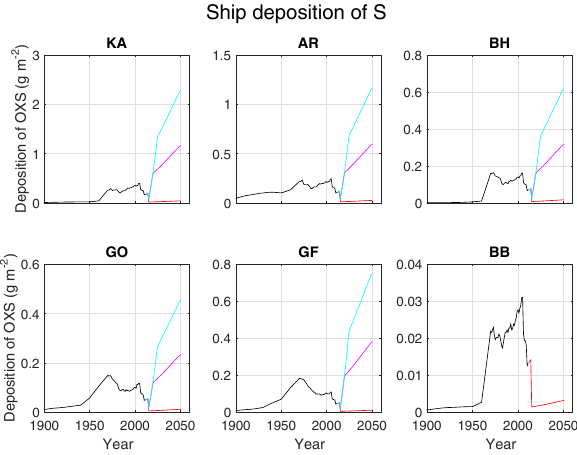
Figure 6. Annual ship deposition of sulfur (mgm − 2 ) in six basins of the Baltic Sea (defined in Fig. 2), for the years 1900 to 2050. The red line corresponds with shipping scenario 3 and the magenta and cyan lines correspond with shipping scenarios 4 and 5, respectively (scrubber + atmospheric deposition). The black line shows histori- cal shipping (derived in Omstedt et al., 2015). It is assumed here that scrubbers are not used in the Bothnian Bay.